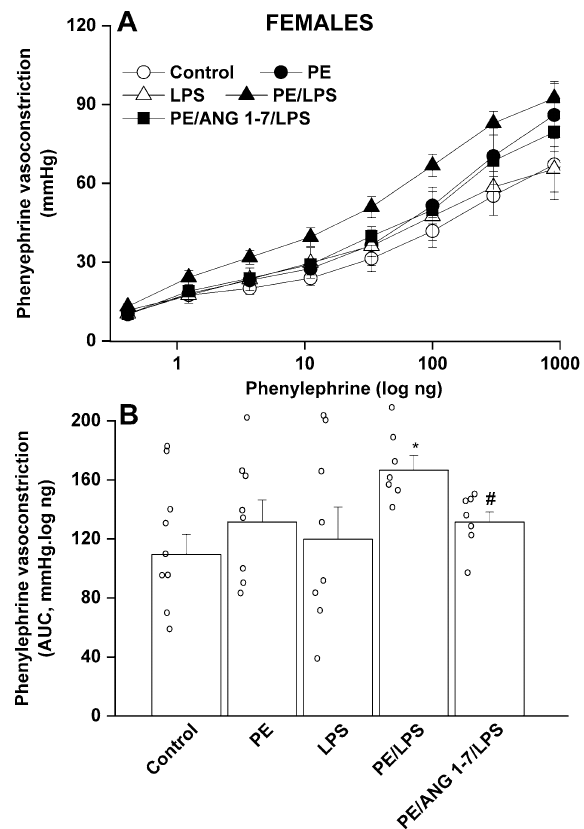
Figure 5. Effect of PE programming on the cumulative vasoconstrictor response curves of phenylephrine ( A ) and AUCs of the phenylephrine cumulative vasoconstrictor response curves ( B ) measured 4-h post LPS challenge (5 mg/kg) in isolated perfused kidneys of adult female offspring. The influence of prenatal administration of Ang1-7 is also shown. Contractile responses were estimated as changes from basal renal perfusion pressure. Values are expressed as means ± S.E.M of 7–8 measurements. ANOVA followed by the Tukey’s post hoc was utilized to measure statistical significance. *P < 0.05 vs. “Control”, # P < 0.05 vs. “PE/ LPS” in the same